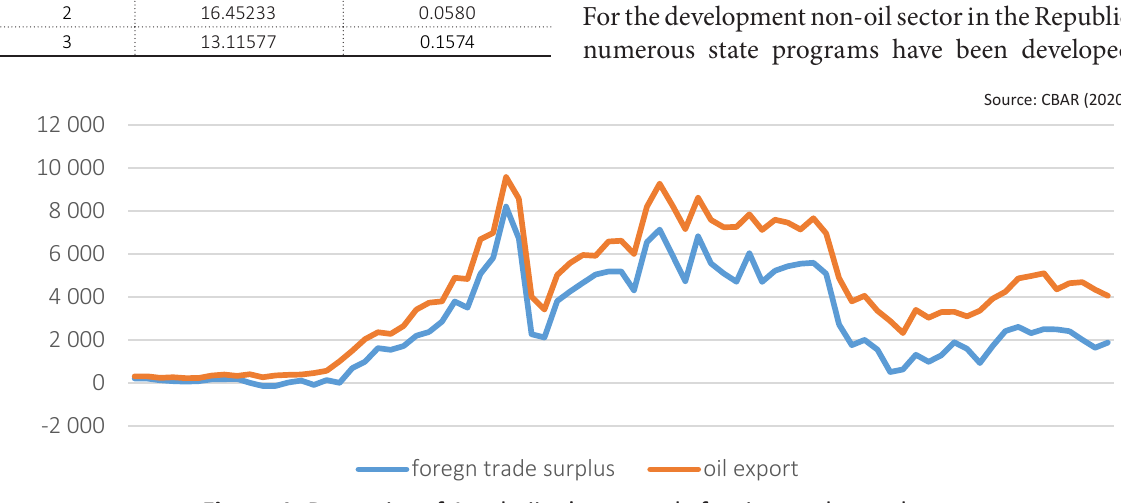
Figure 1. Dynamics of Azerbaijan’s quarterly foreign trade surplus and oil exports (2000–2019, in USD